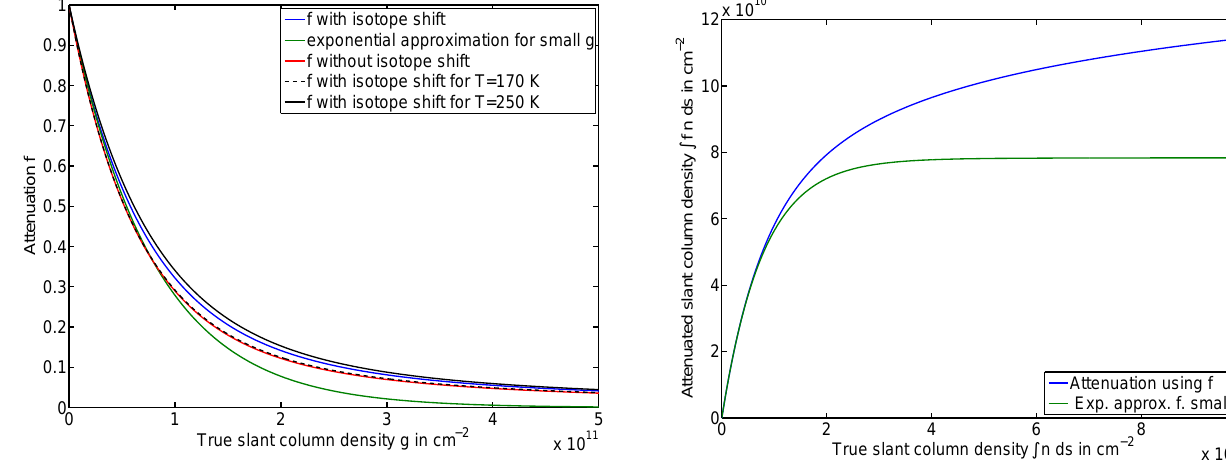
Fig. 20. Plot of attenuated slant column densities (SCDs) versus the true SCDs for the Mg 285.2nm line. The attenuated SCDs are determined using f , as well as the exponential approximation of f for small true SCDs. Typical measured SCDs ( y axis) in the peak region for Mg are 6–8 × 10 10 cm − 2 . The exponential approximation cannot be used in the retrieval, since it is already saturated below 8 × 10 10 cm − 2 . For Mg the self-absorption effect is so strong that the measured SCDs are a factor 3 to 4 smaller than the true SCDs in the Peak region. For Mg + (not in the plot) the conversion factor is close to